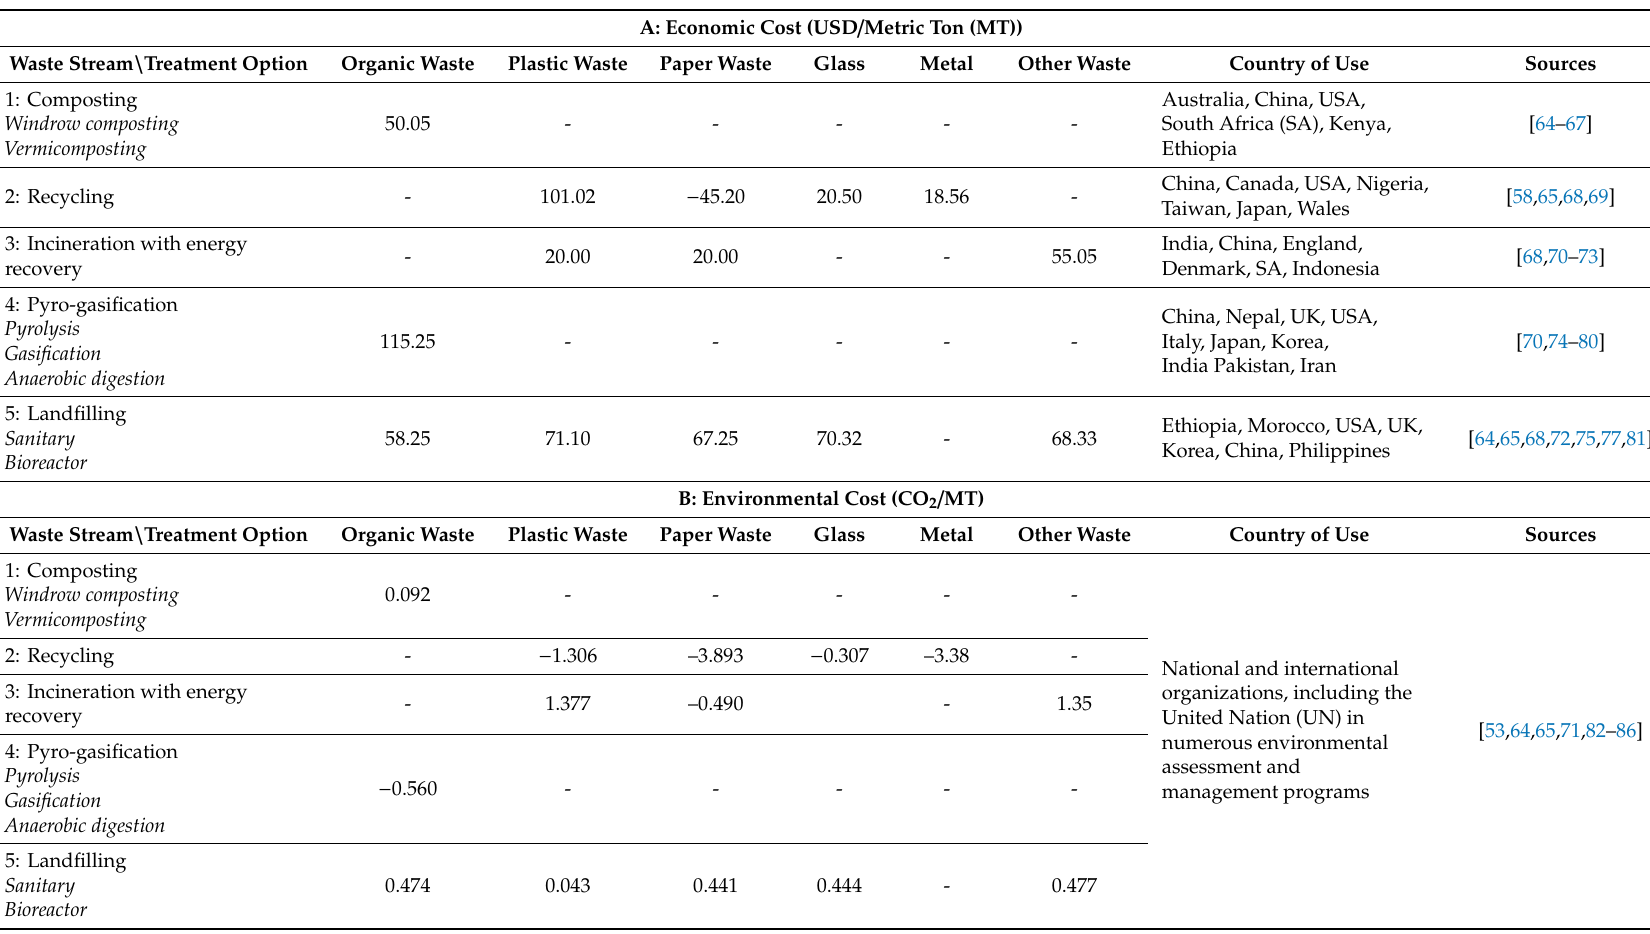
Table 2. Average economic and environmental cost of municipal solid waste treatment options for all waste streams in Dar es Salaam. A: Economic Cost (USD / Metric Ton